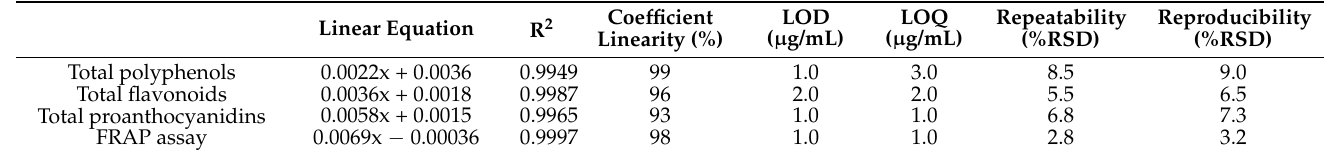
Table 2. Validation parameters for antioxidant determination by spectrophotometry. Linear Equation R 2